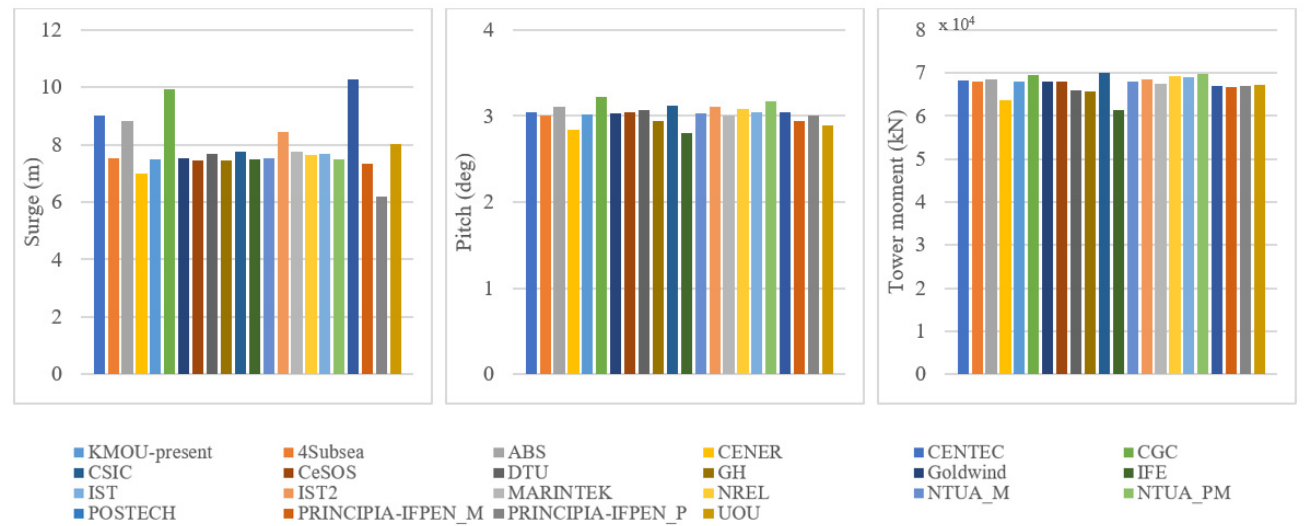
Figure 6. Fully coupled technique validation result (Turbulent (IEC Kaimal) model, V = 11.4 m/s, Irregular H s = 6 m, T p = 10 s).